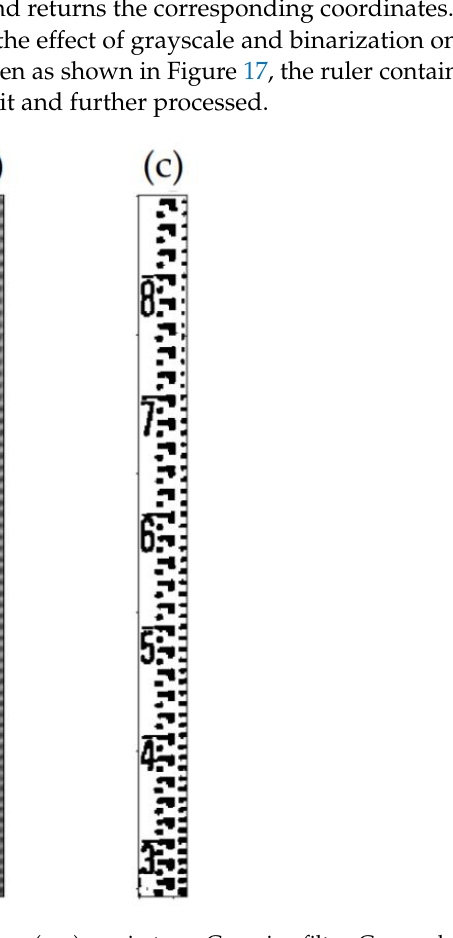
Figure 16. The ruler images ( a – c ) are, in turn, Gaussian filter, Grayscale processing, and binarization from Figure 15d.